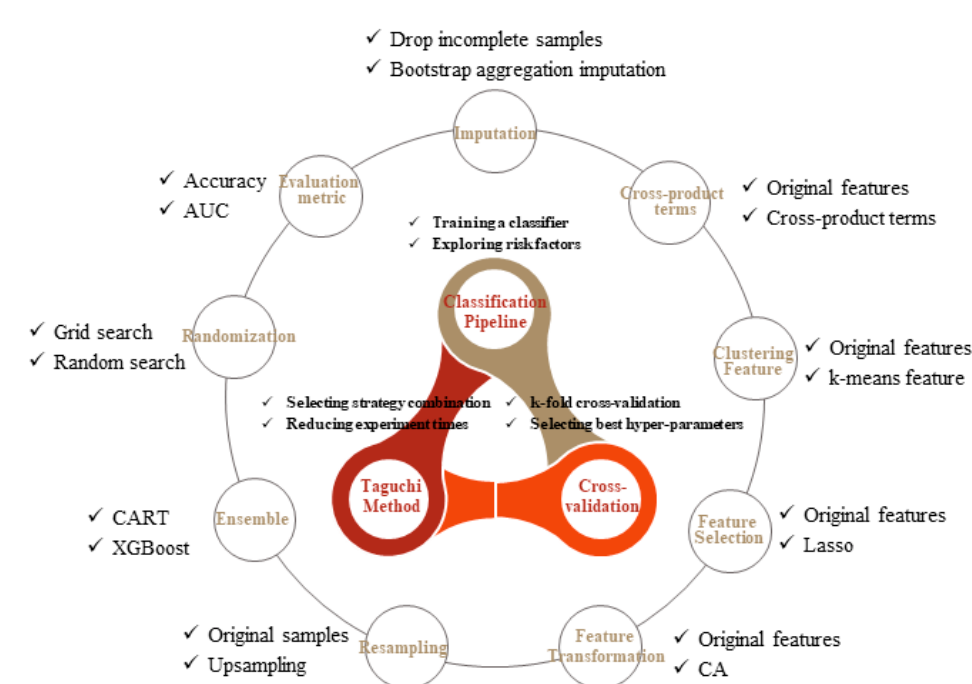
Figure 1. The components of proposed auto-ML scheme. CART, XGBoost, AUC, Lasso and CA are the abbreviations of classification and regression tree, eXtreme gradient boosting extreme, area under curve, least absolute shrinkage and selection operator, and correspondence analysis respectively.